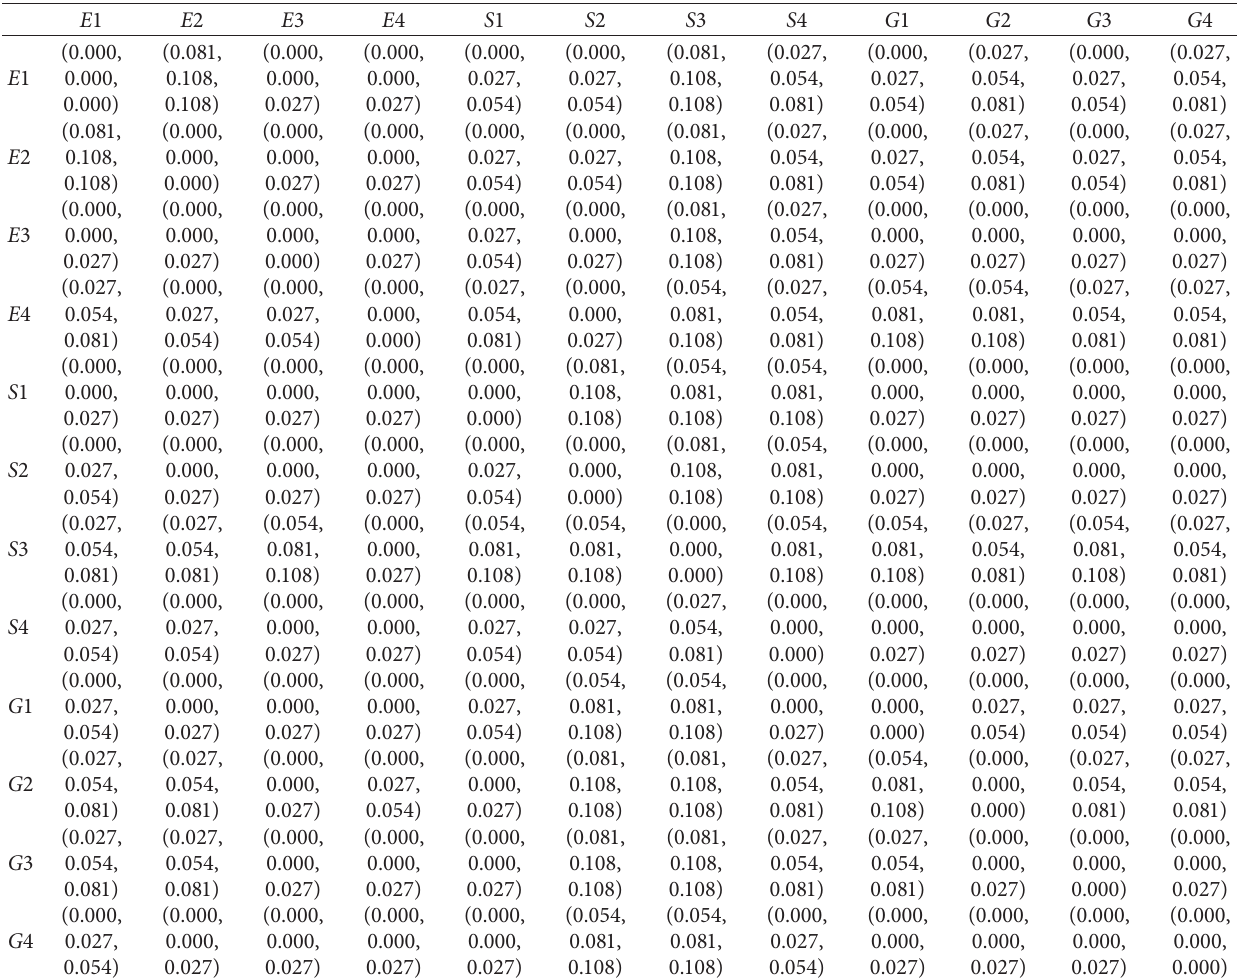
Table 39: Normalized matrix of sustainability criteria in fuzzy